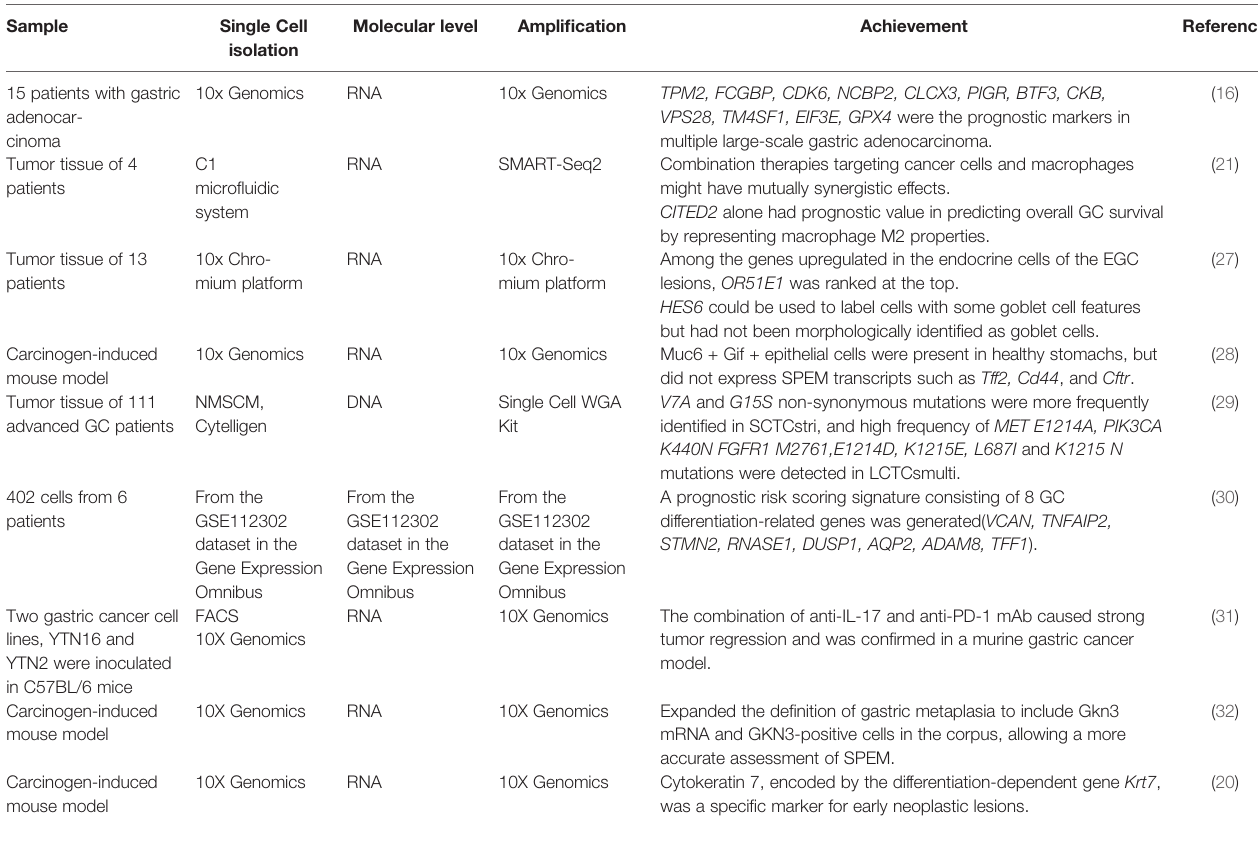
TABLE 3 | SCS in diagnosis and treatment of gastric